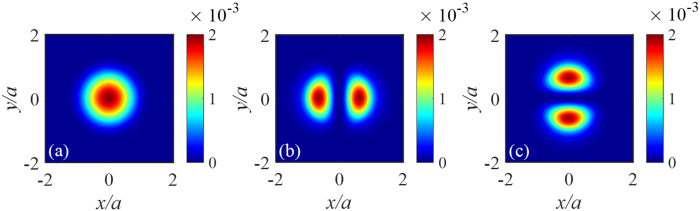
Local capture fraction of Rayleigh back-scattering in few-mode fibers.(a), (b) and (c) are for the excitations by LP01, LP11a, and LP11b modes, respectively.